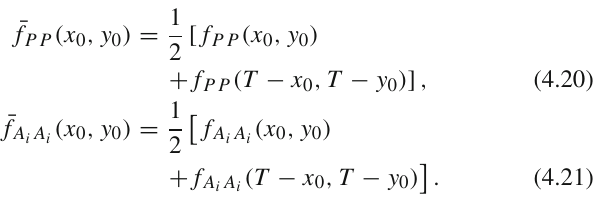
Table 1 Simulation parameters of our ensembles. The columns show the lattice sizes, the gauge coupling β = 6 / g 2 parameter, the twisted mass parameter μ , the pseudoscalar mass in t 0 units, the hadronic scale t 0 / a 2 defined in [24], the lattice spacing in fm fromthescale t 0 [12]andthetotalstatisticsinmoleculardynamicsunits.